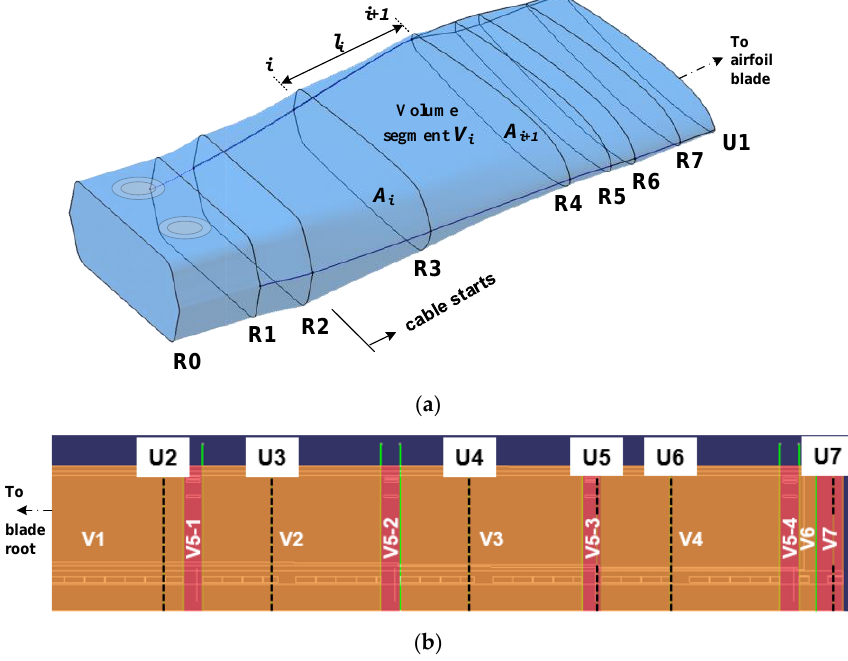
Figure 13. Subdivision of blade segments for estimating interior volumes. ( a ) 3D layout for blade root region. ( b ) Planar view of blade airfoil region (inboard region not shown).